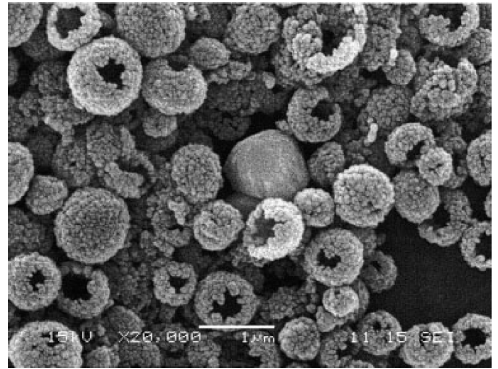
Figure 7. SEM micrographs of CaCO 3 ‘hollow closed’ microspherical particles obtained in the presence of a triblock copolymer PEG750- b -[(P(O)(H)O(CH 2 ) 6 ] 17 - b -PEG750 for concentration of modifier 3 g·L –1 . Reprinted with permission from [53]. Copyright (2005) Wiley-VCH Verlag GmbH & Co.